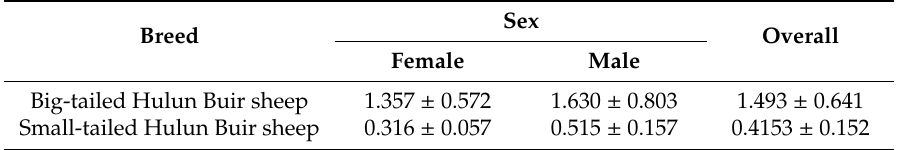
Table 1. Summary statistics of weights of tail fat of big- and small-tailed Hulun Buir sheep lines (kg).